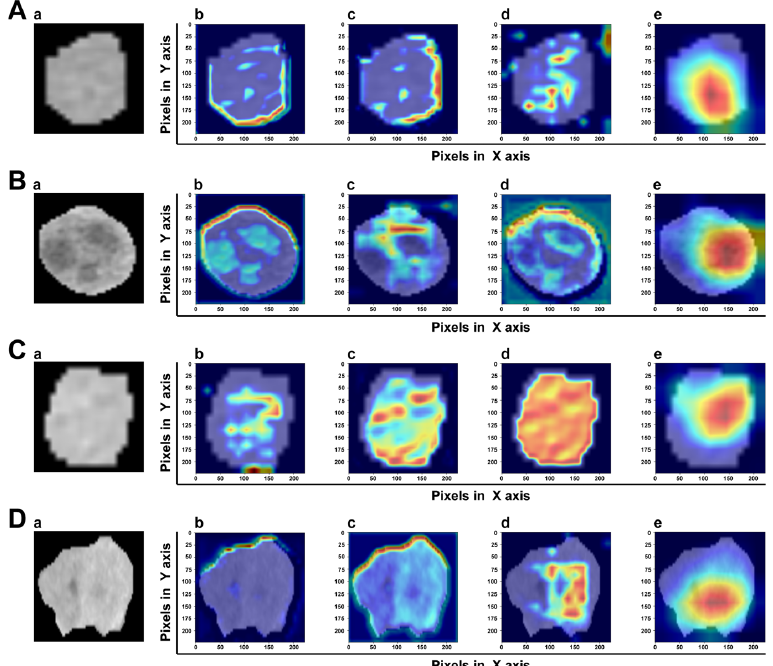
Figure 8. The visualization of attention which MVI ‐ TR paid in the input ROIs by Grad ‐ CAM. The top two rows ( A , B ) are the ROIs of two samples with MVI, while the bottom two rows ( C , D ) are without MVI. In each row, ( a ) is the original image. ( b – d ) Support for the class with MVI according to various visualizations for features of different layers in MVI ‐ TR. ( e ) Is the final feature map to predict the MVI status.